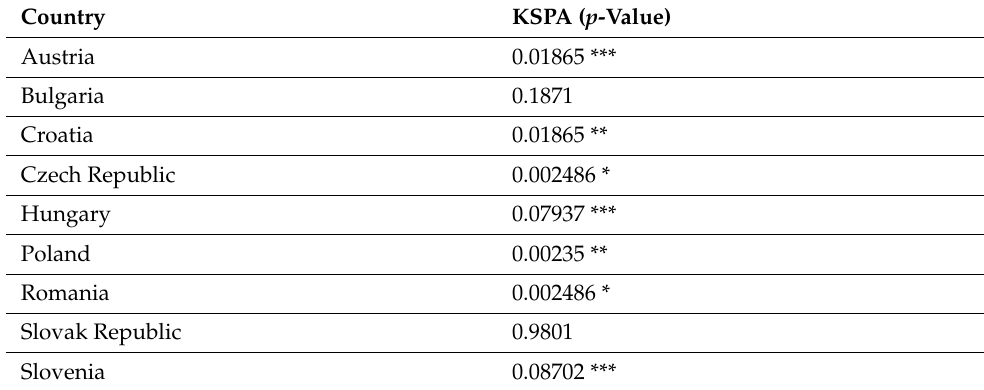
Table 4. The results of the Kolmogorov–Smirnov Predictive Accuracy (KSPA) test ( p -values).